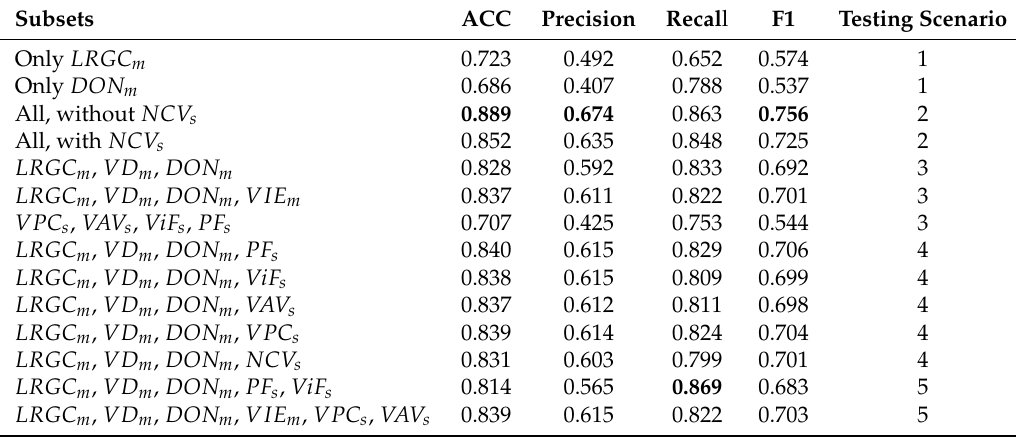
Table 5. Results from testing different subsets of the proposed metrics. Each of the subsets is used to train the best performing classification method from the first testing scenario AdaBoost. Different subsets are created to test the posed question in Table